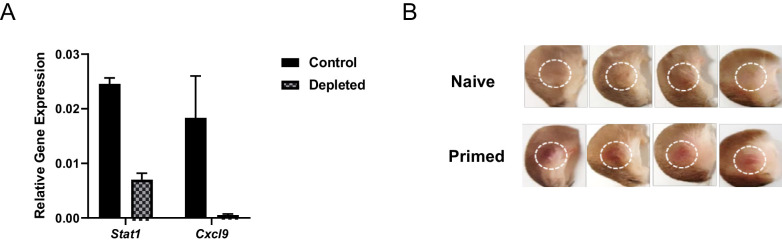
Innate memory signature is lost in clodronate treated mice.(A) Wt mice were i.d. infected with S. aureus (107 CFU in 10 µl PBS) and 2.5 weeks later i.d. injected with either clodronate liposomes or control liposomes. After an additional 1.5 weeks total dermal CD64hi Mφ were sorted and RNA expression analyzed by qPCR (data represents two independent experiments). (B) Lesion pathology of wt mice i.d. infected with S. aureus (107 CFU in 10 µl PBS) and i.d. (re-)infected 3 weeks later (primed) or for the first time (naïve) with fixed bacteria (108 CFU in 10 µl PBS).